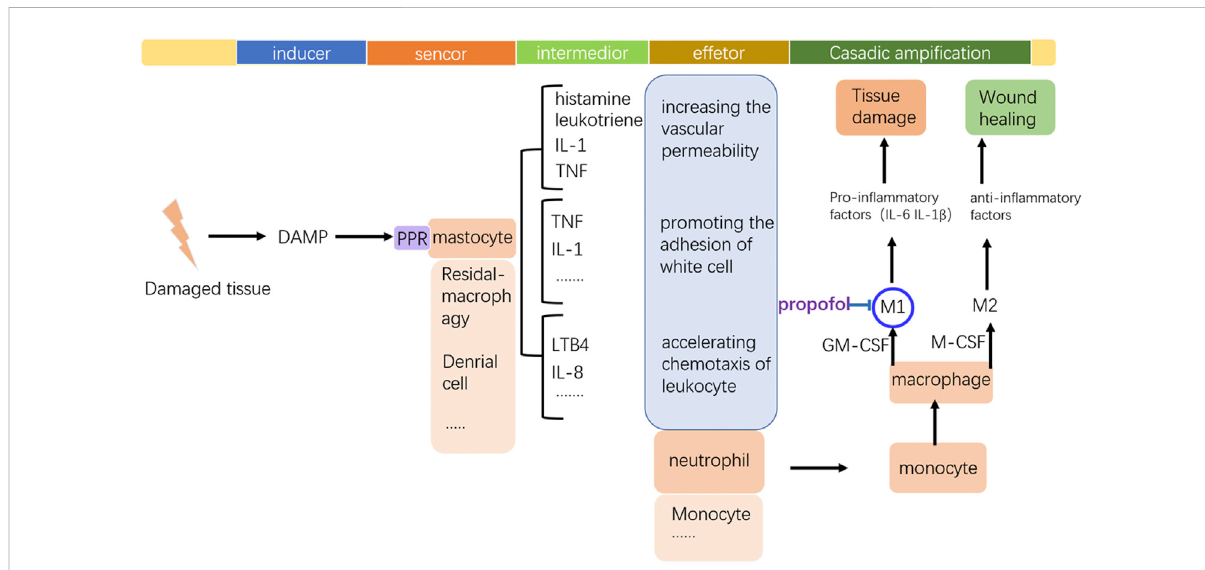
FIGURE 5 Frame of in fl ammation and the key modulating point of propofol to the monocyte – macrophage system. Tissue damage stimulates the occurrence of in fl ammation by the DAMP release. By inhibiting M1 polarization of macrophages, propofol may prevent the local tissue from excessive in fl